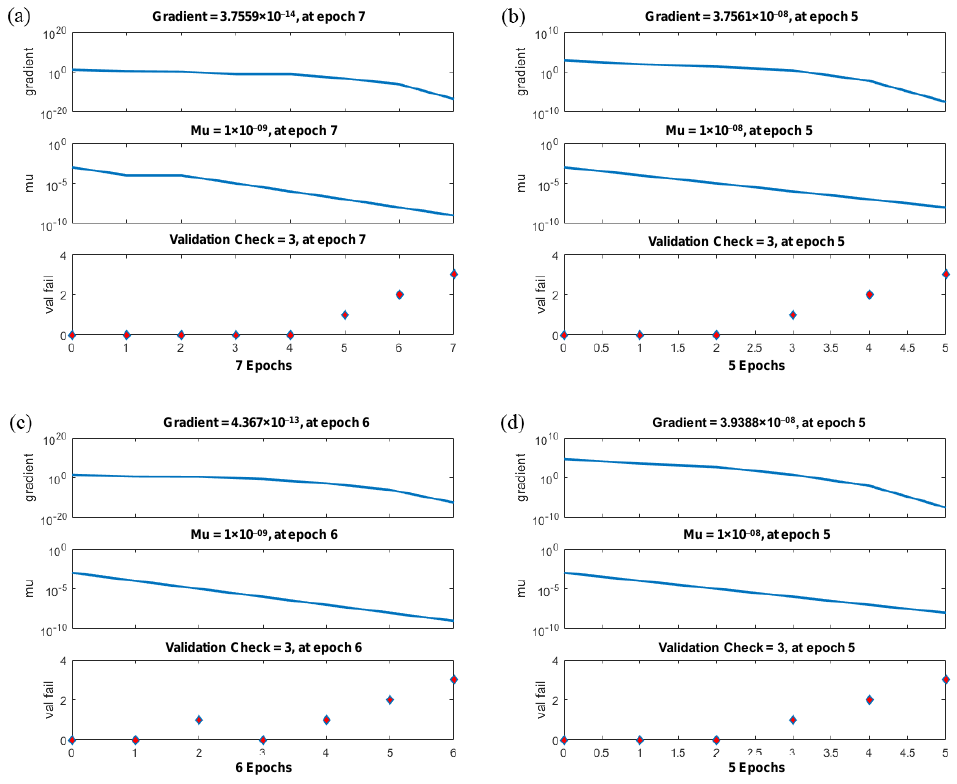
Figure 12. Training state in ANN models for prediction of ( a ) Id 2 , ( b ) SRH, ( c ) UPV, and ( d ) UCS. To assess the performance of the results of the ANN models, the statistical parameter was calculated and is presented in Table 10. As can be seen, R values in all models are equal to 0.99. RMSE values, except in model 4 which predicted UCS, are very low, and in the predictive model of UPV is equal to 0.06. The performance index of the UPV model is equal to 99.94, which is high. Despite high values of RMSE and MAPE in model 4, the VAF value is higher than other models. The significance level in all models is equal to 0.000,